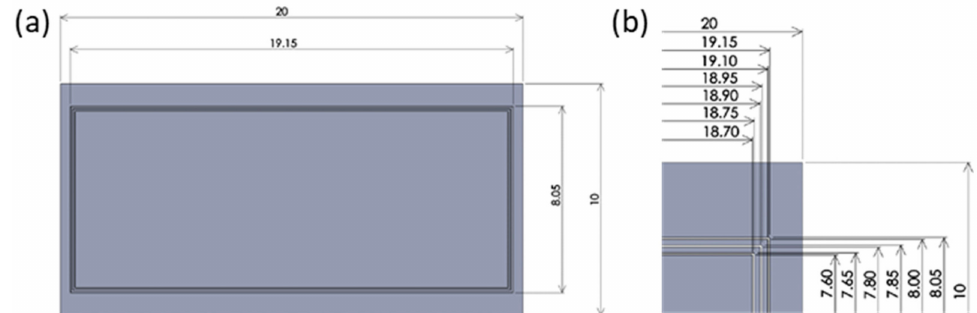
Figure 3. Geometry of a closed loop patterns on the CAD data. ( a ) General pattern of three closed loop, ( b ) details of closed loop patterns.